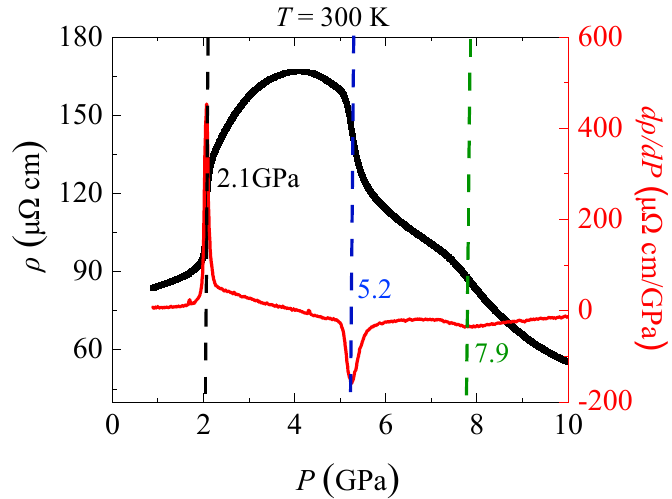
Figure 2. Pressure dependence of, ρ , of CeZn single crystal at T = 300 K (black line) and the derivatives d ρ / dP (red line).